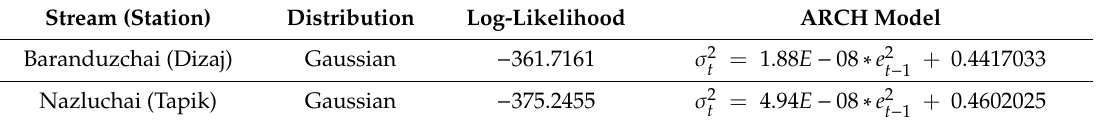
Table 5. ARCH model estimation using Gaussian distribution for Dizaj and Tapik stations. Stream